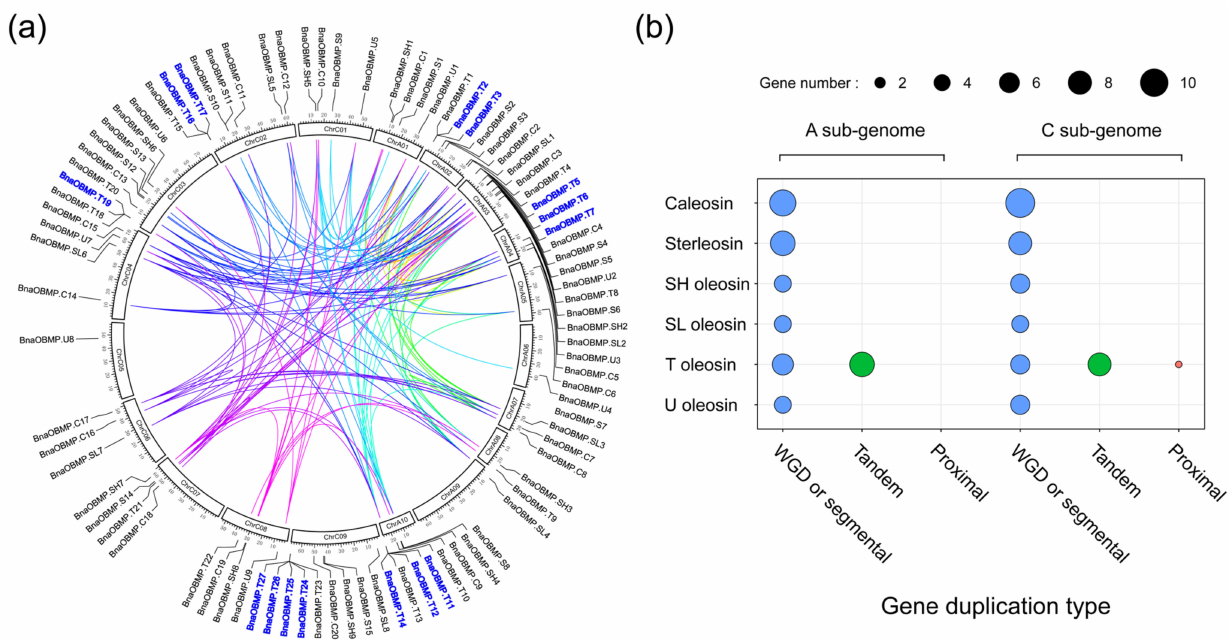
Figure 3. Collinear correlations and gene duplication type of the BnaOBMP family genes. ( a ) Collinear correlations of OBMP genes in B. napus . The circle boxes represent chromosomes with names. The scale on the circle is in mega bases. BnaOBMP gene IDs on the chromosomes indicate their physical positions. The inner lines indicate the collinear correlations between BnaOBMP gene pairs. Gene IDs marked by a blue font signify tandem duplication clusters. ( b ) The gene numbers for each family of BnaOBMPs with different gene duplication types. The x - and y -axes represent the gene duplication type and OBMP gene subfamilies, respectively. The size of the circles indicates the gene number. The A and C subgenomes are shown in the left and right panels,